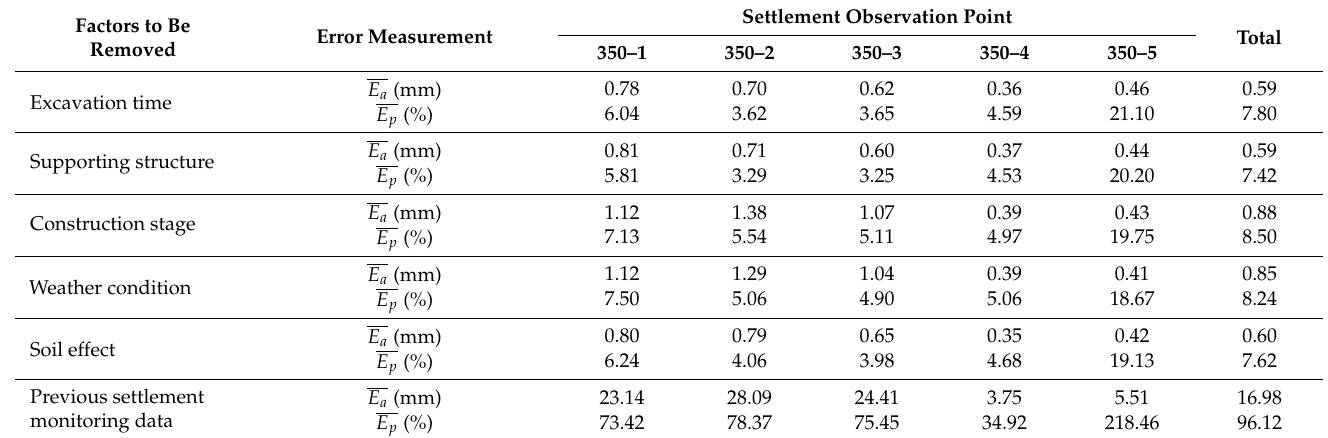
Table 3. Average prediction errors of BPNNs trained using different input data.